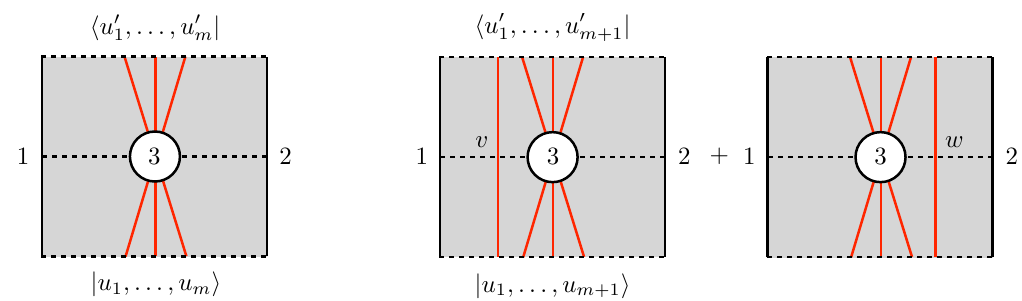
Figure 18 . Examples of form factors for the charge m dilaton-like operator. Form factors with k > m magnons have kinematical singularities stemming from magnons decoupling on the far left or far right. In the diagonal set up the left and right boundary are identical and one obtains, after averaging over all the decoupling paths, the same residue as for the matrix elements of a local operator in a local QFT. The left panel shows the (cid:12)rst non zero form factor with k = m ; all the magnons hit the operator and there is no kinematical singularity. The next panels show the form factor with k = m + 1; a magnon can then travel on the left- or right-hand side of the operator. contour